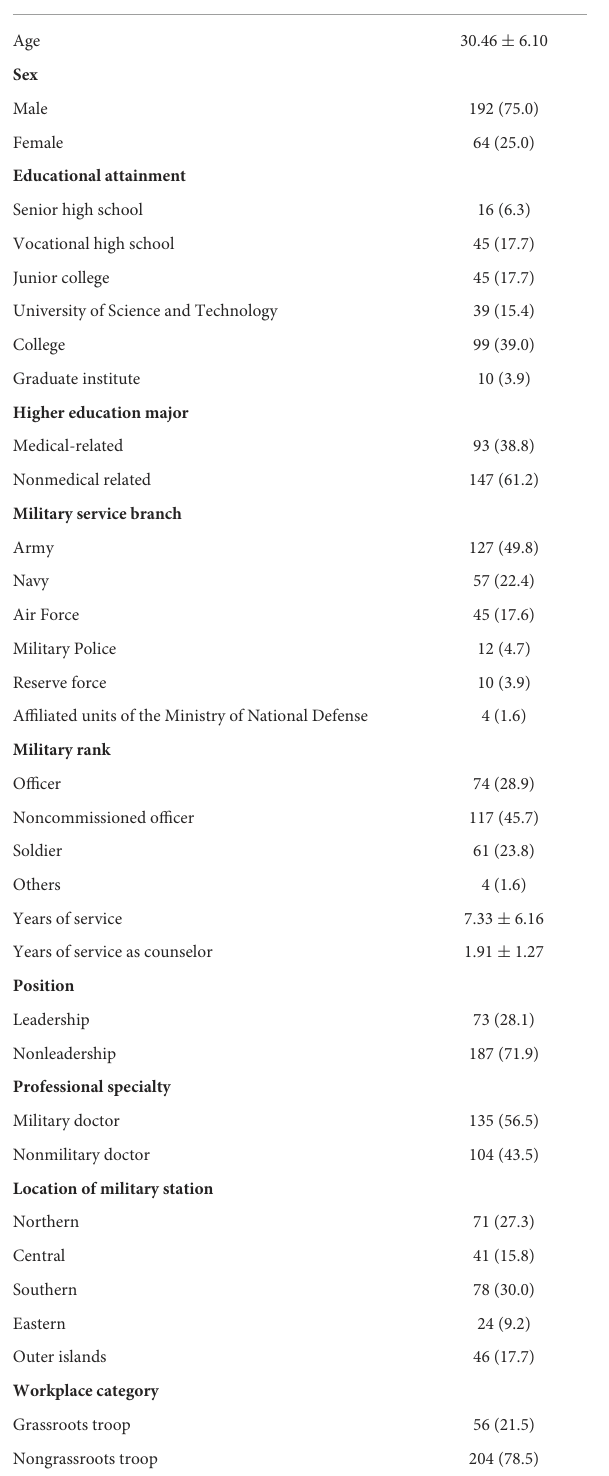
TABLE 2 Demographic characteristics of study